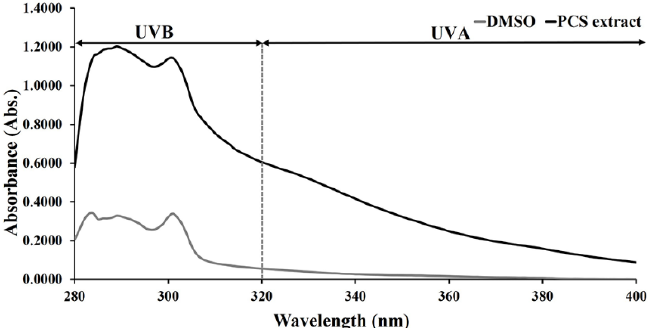
Figure 1. A spectrum of UV absorbance of PCS extract. The gray line shows UV absorbance of DMSO used as a negative control. The black line shows UV absorbance of PCS extract at 1 mg/mL (in DMSO). The UV absorbance was measured every 1 nm covering a range of 280–400 nm UVA and UVB wavelengths using a spectrophotometer.